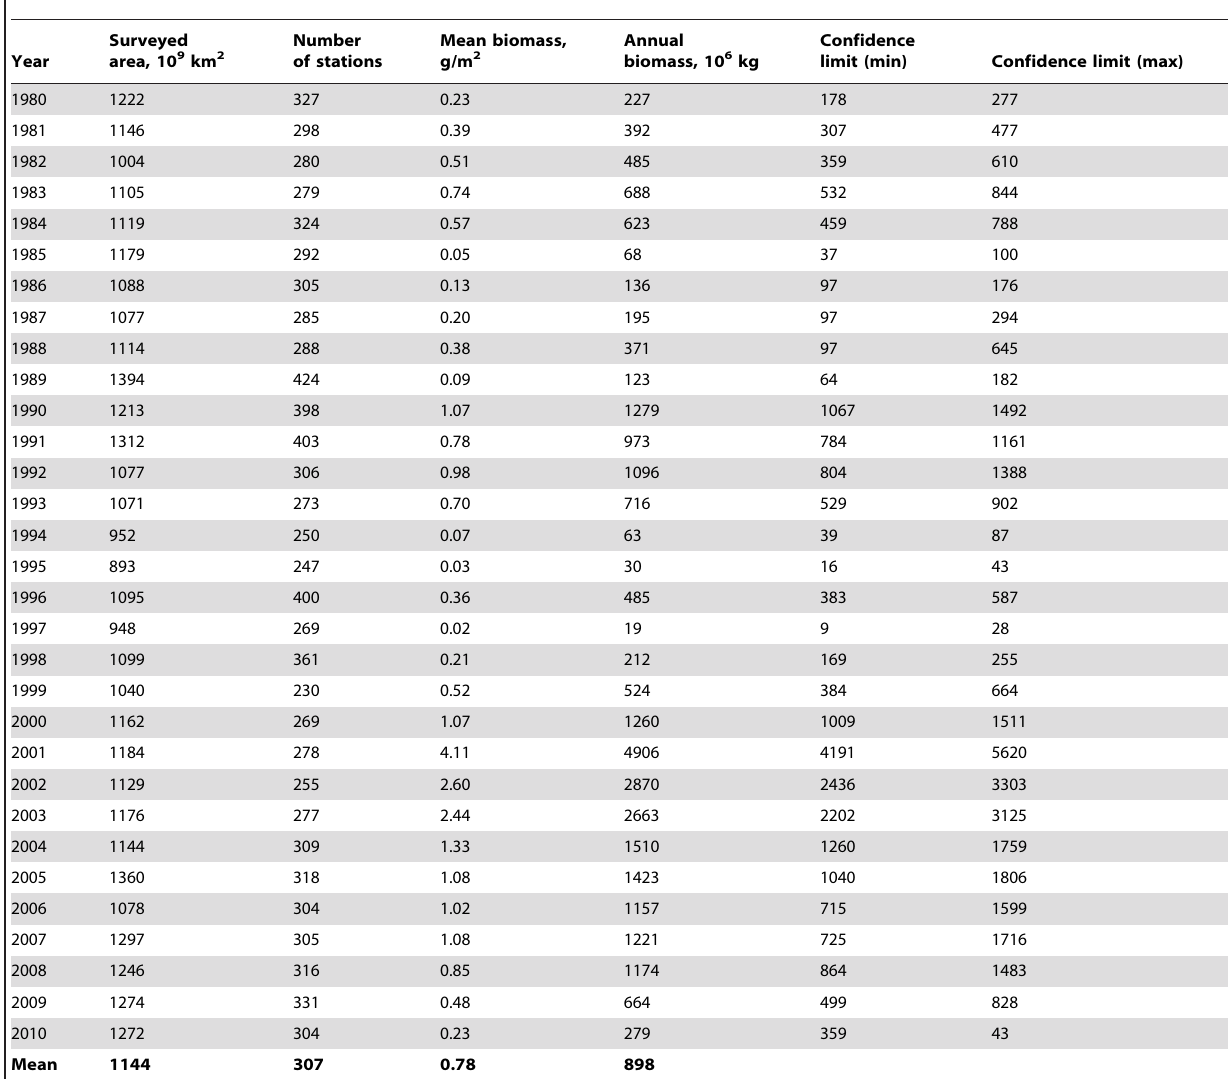
Table 1. Estimates of Barents Sea jellyfish biomass (10 6 kg) with 95% confidence interval for the period 1980–2010.